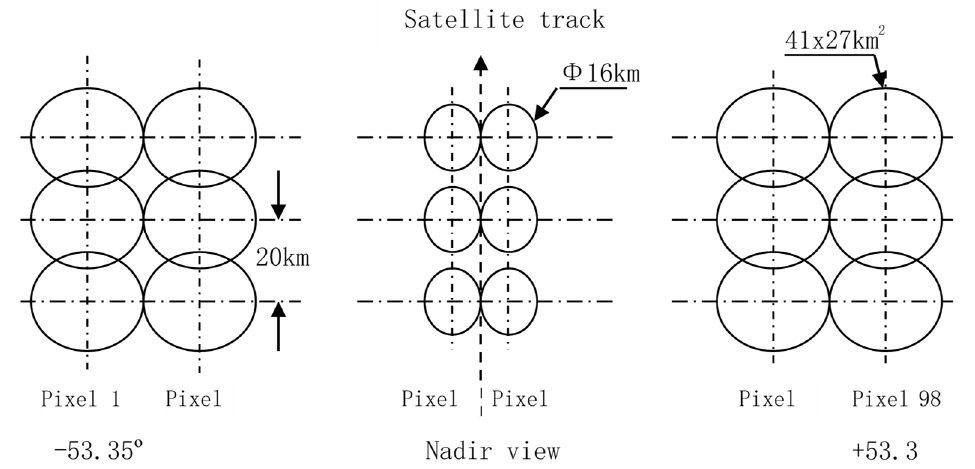
Figure 2. Pixels along the scanning line of FY-3C MWHTS on orbit.